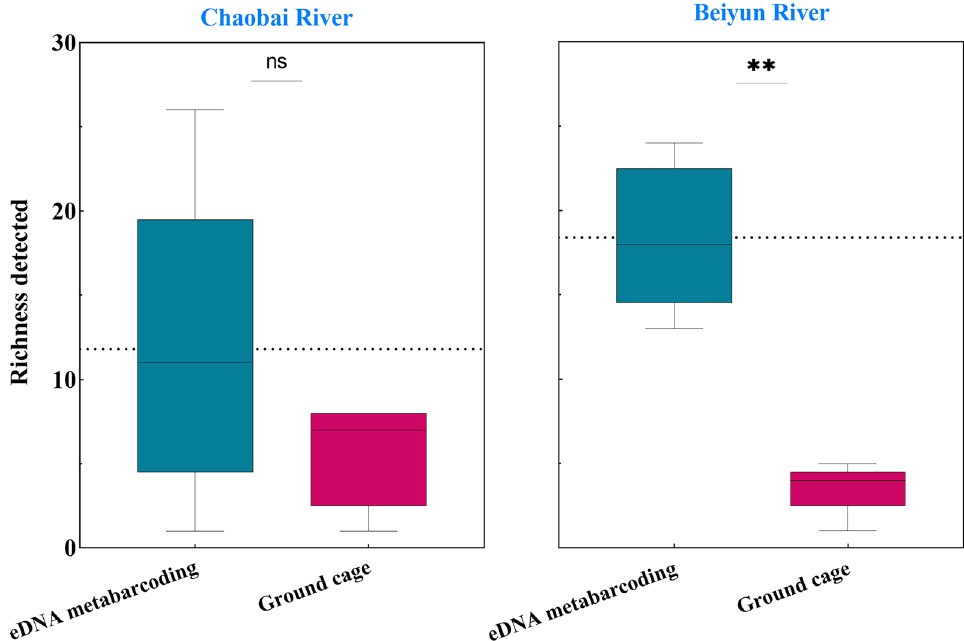
Figure 5. Richness detected at each site using eDNA metabarcoding (red) or ground cage fishing (blue). Differences between the methods were determined using t-tests (number of species followed a normal distribution); Chaobai River P > 0.05; Beiyun River P < 0.05.